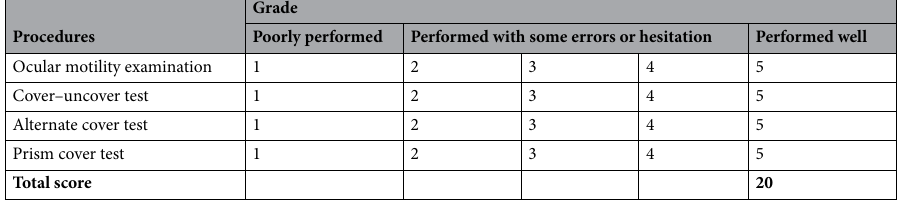
Table 2. Performance score rating standard of the diagnostic procedure for strabismus. The performance score was evaluated on a scale of 1 to 5, where 1 meant “Poorly performed” and 5 meant “Performed well”.